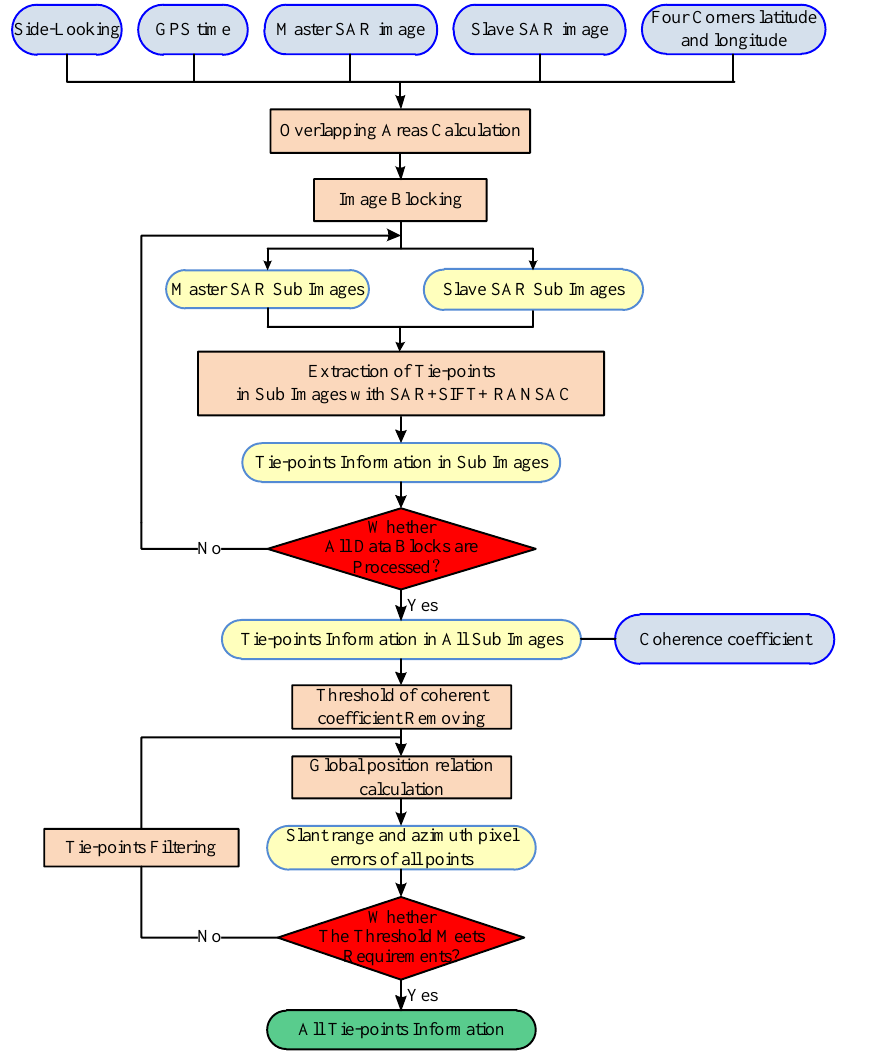
Figure 2. Flow chart of automatic extraction of tie-points.